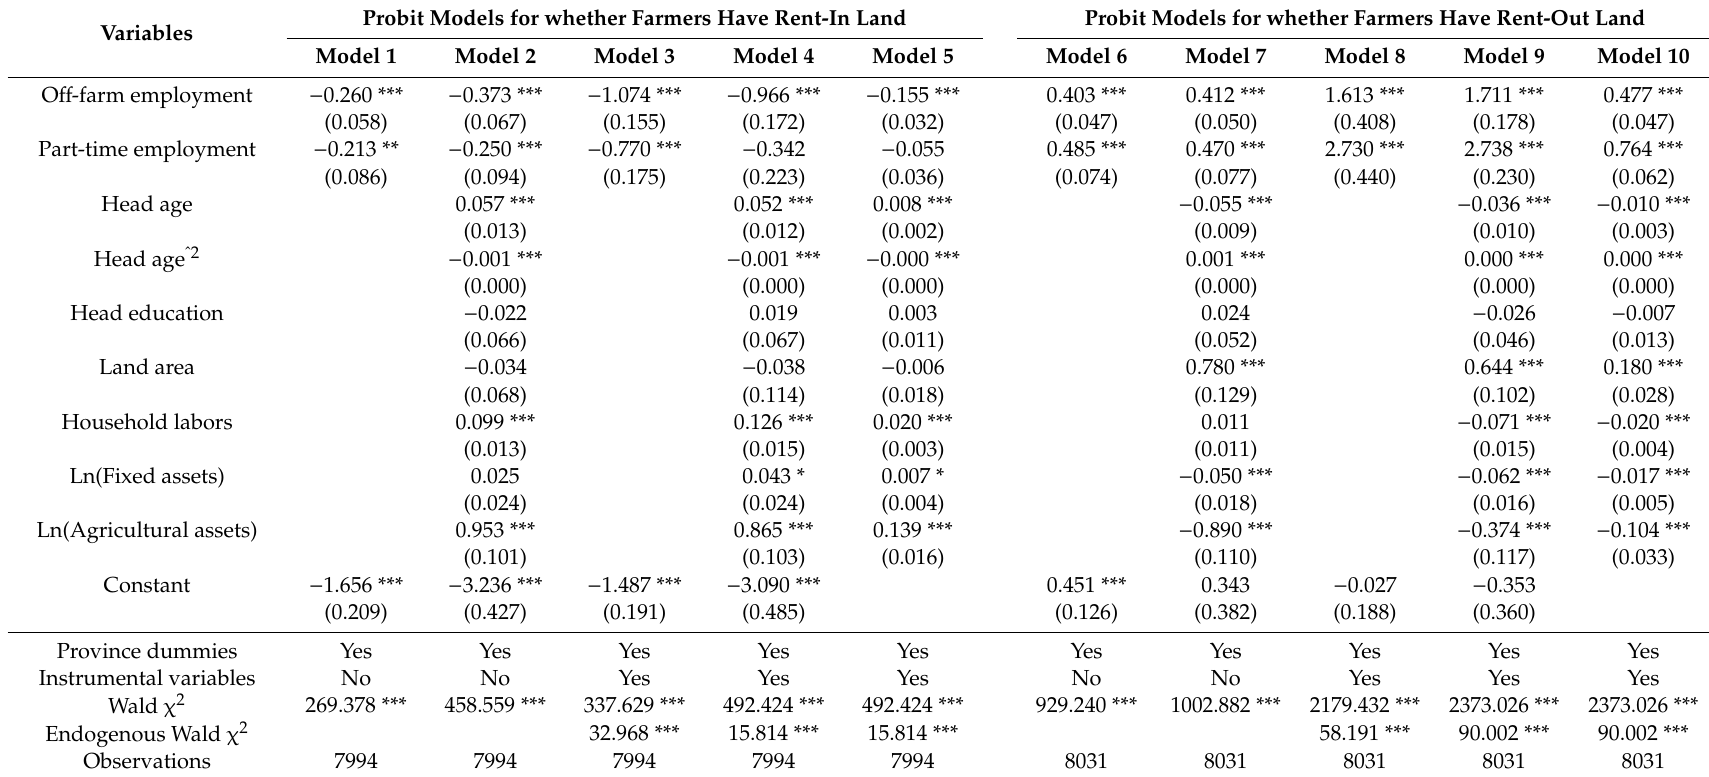
Table 2. Probit models estimation results of land transfer direction of